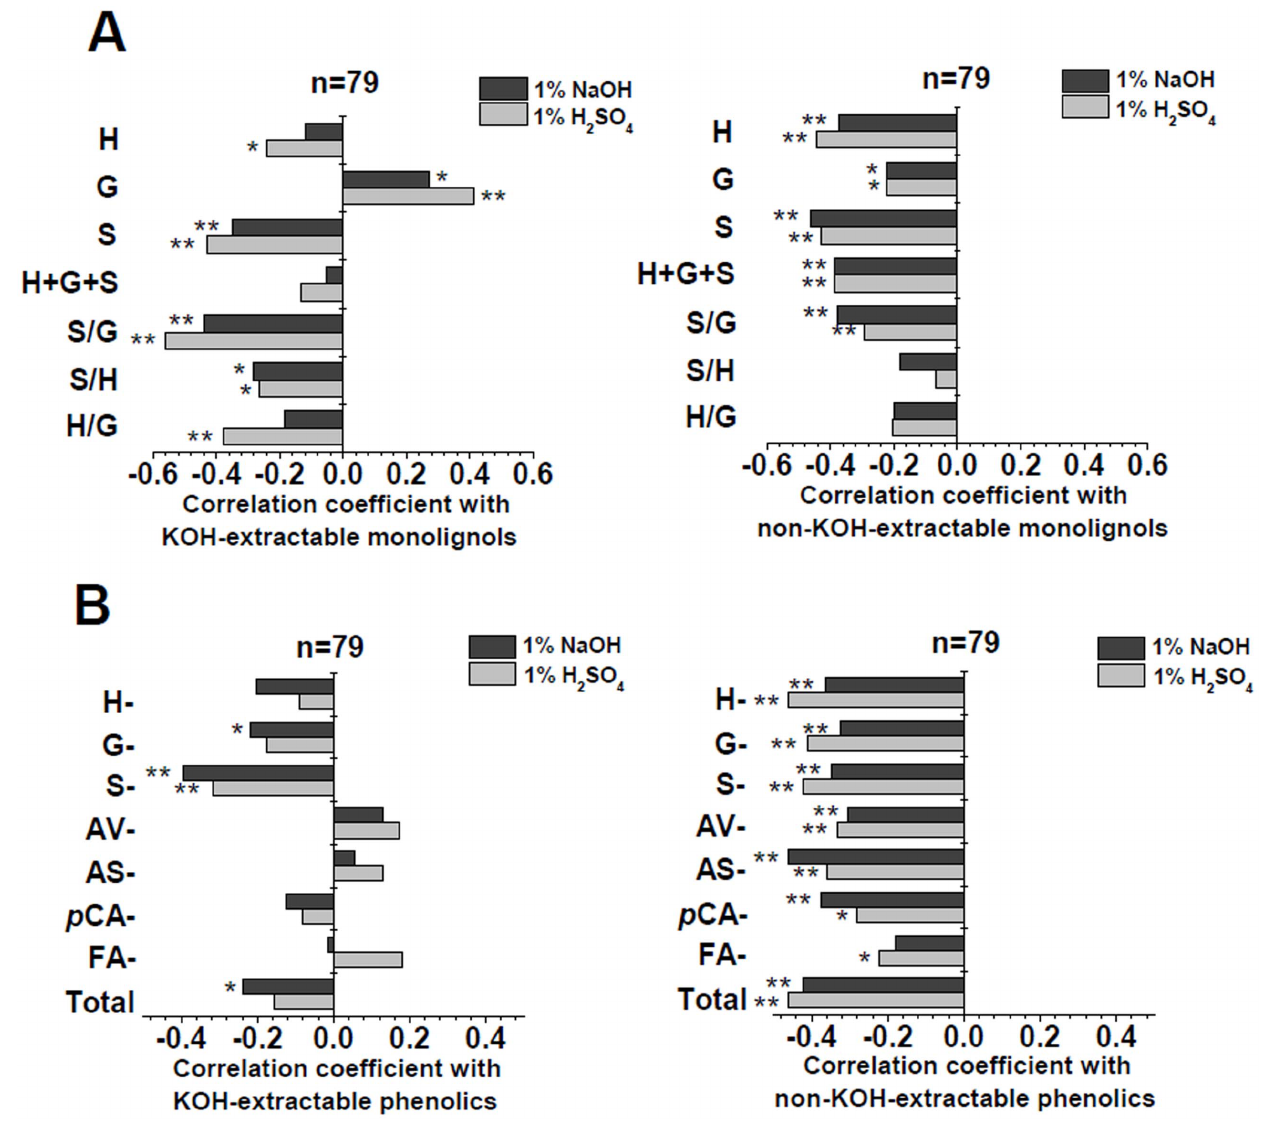
Figure 4. Correlation analysis among monolignols, seven interlinked-phenolics and biomass saccharification in Miscanthus . (A) The KOH-extractable and non-KOH-extractable monolignols; (B) The KOH-extractable and non-KOH-extractable interlinked-phenolics. * and ** Indicated the significant correlation coefficient values at p , 0.05 and 0.01 (n=79), respectively.